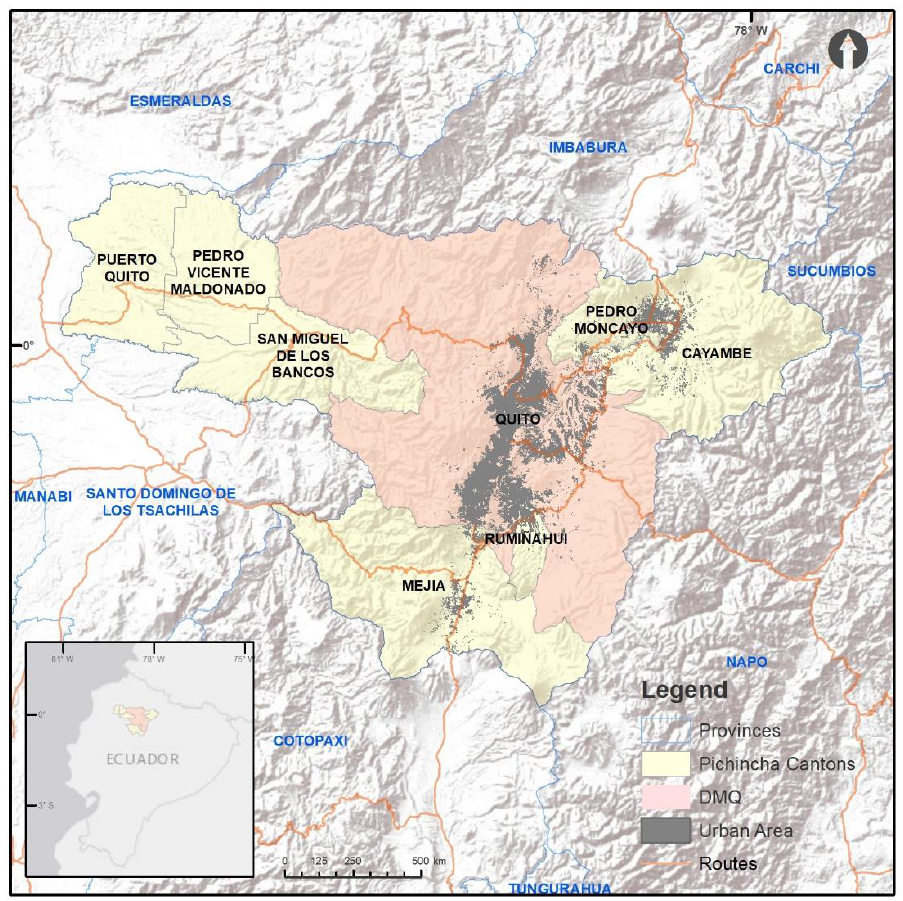
Figure 1. Spatial location of the Metropolitan District of Quito (DMQ) and its neighboring cantons and parishes in the Province of Pichincha.